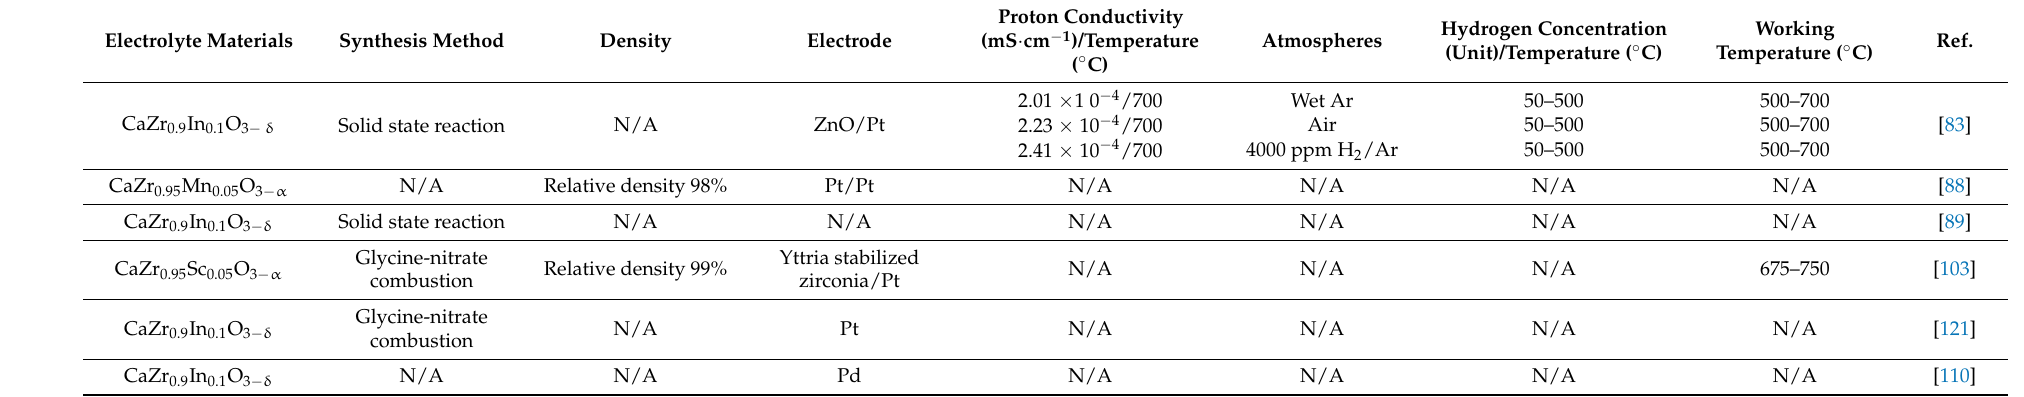
Table 3. Zirconate based hydrogen sensors.